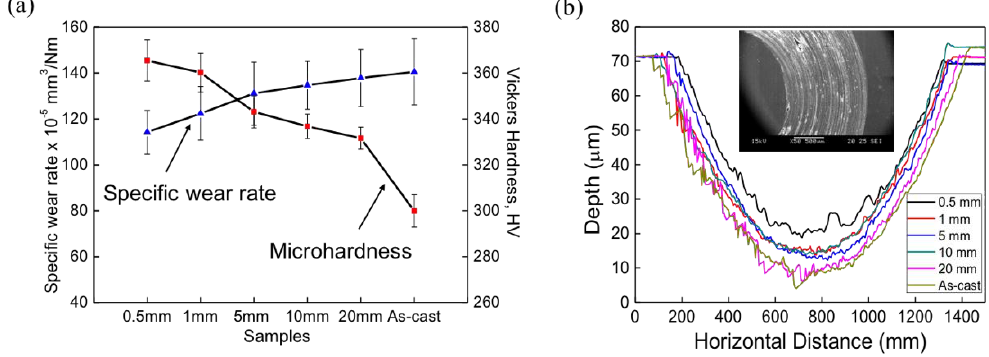
Figure 10. ( a ) Specific wear rates and microhardness values of EBM-built and as-cast Ti64 samples; ( b ) Surface profiles measured across the wear tracks of the worn Ti64 samples.